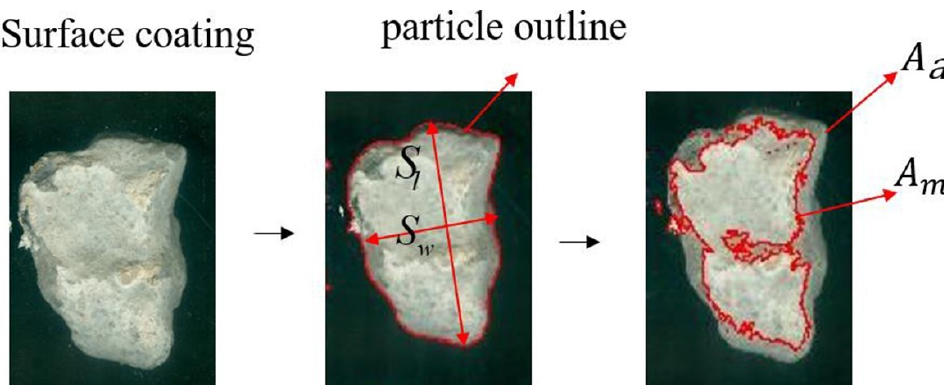
Figure 4. Illustration of shape characteristic indexes.